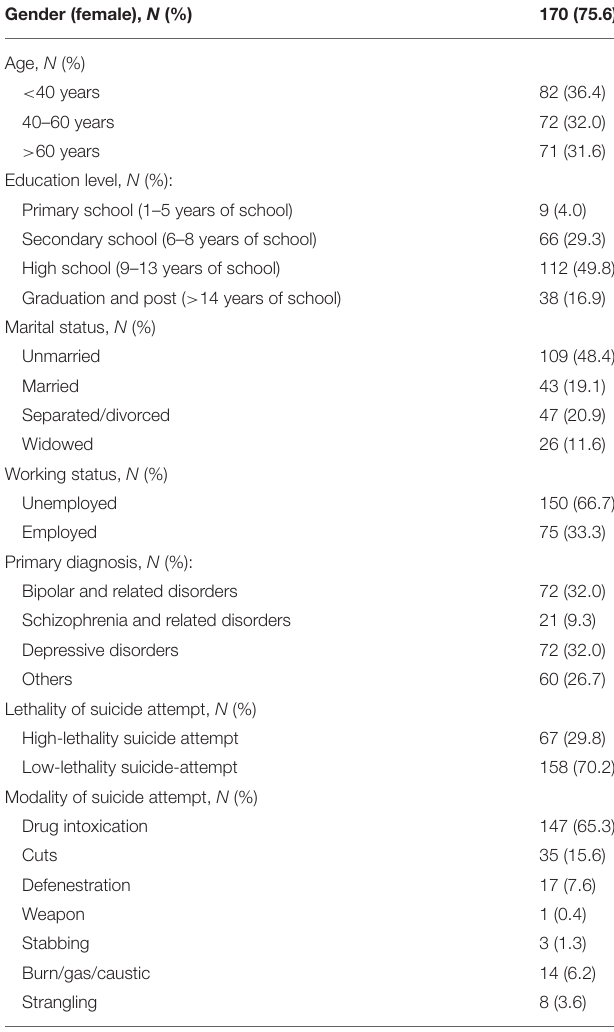
TABLE 1 | Sociodemographic and clinical characteristics of the total sample ( N =